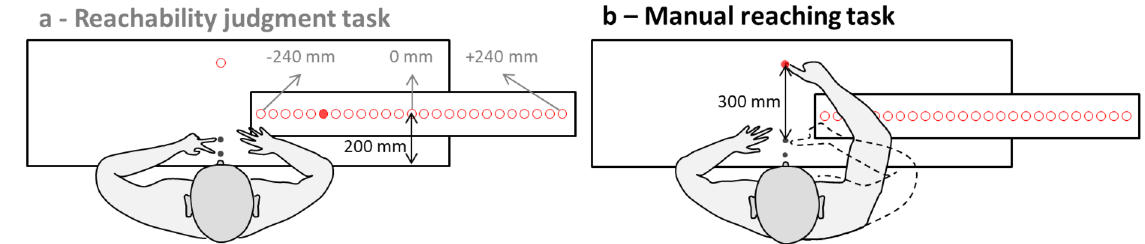
Figure 1. Experimental setup. ( a ) Reachability judgment task: participants had to judge whether a target illuminated on their right side was reachable or not, pressing the closer response button with their left index for “reachable” or the more distant button with their middle finger for “unreachable”. The 0 mm target position was physically adjusted for each participant to correspond to the maximum physical distance reachable with the arm fully stretched. ( b ) Manual reaching task: participants had to reach the visual target with their right index as accurately and as fast as use, for the reachability judgment task, 25 visual targets which were aligned horizontally in the participants’ right hemispace (perpendicularly to the reach movement in the mid-body sagittal axis and according to the direction of the perturbation induced by the Coriolis force). The reachability targets were located, for each individual, between ± 240 mm (inter-target distance 20 mm) of the maximum arm length (see Fig. 1 and Procedure). On the horizontal table, two response buttons were positioned close to the participant, one located 1 cm from the table’s proximal edge and the other located 1 cm farther away. Participants operated these buttons with their left hand to respond in the reachability judgment task (near button for responding ‘reachable’ and far button for responding ‘non-reachable’ after a given was illuminated). The far button in the reachability judgment task also served as the starting position for the right hand in the manual reaching task, and could be illuminated with a light-emitting diode. An infrared active marker was taped to the right index fingertip, whose position was sampled at 350 Hz using an optical motion tracking system (Codamotion cx1 and MiniHub, Charnwood Dynamics Ltd, Leicestershire, UK), to record hand movement kinematics during the manual reaching task. Response buttons were sampled at 800 Hz to record reachability judgments. The experimenter controlled the tracking system, the motorised platform and the presentation of the visual targets from an adjacent room via customised software (Docometre) governing a real-time acquisition system ADwin-Pro (Jäger, Germany). Procedure. The procedure was identical to that used in our previous studies 26,33 except for the gradual intro- duction of the platform rotation. Once seated on the platform and before the experiment started, participants wore occluding glasses to prevent them from viewing the target array. They were then asked to fully stretch out their right arm in the fronto-parallel plane: this allowed the experimenter to match the position of each partici- pant’s index fingertip, arm fully stretched, with the position of the central target in the array used for the reach- ability judgment task. The individually-adjusted position of the central target thus corresponded to the actual maximum distance that was physically reachable by each participant 21,26,54,55 . After this personalized adjustment of the setup, the occluding glasses were removed and participants were allowed to open their eyes in the dark room. Manual reaching task. In the manual reaching task, each trial began with the right index positioned at the start- ing hand location. The visual target was flashed for 200 ms after a 100 ms auditory tone, followed by a random period of 500–1000 ms. As soon as the visual target was turned on, participants had to reach toward it as fast and accurately as possible with the right index. The visual target was covered by a plexiglass plate and neither tactile nor visual feedback was available to participants. These were asked to maintain their final hand position once the finger touched the horizontal board. 3.5 s after the start of the reaching movement, the LED at starting hand location was turned on: this indicated the end of the trial and signaled to participants that they should move their hand back to the start position and prepare for the next trial. No explicit instructions were given with respect to hand path.